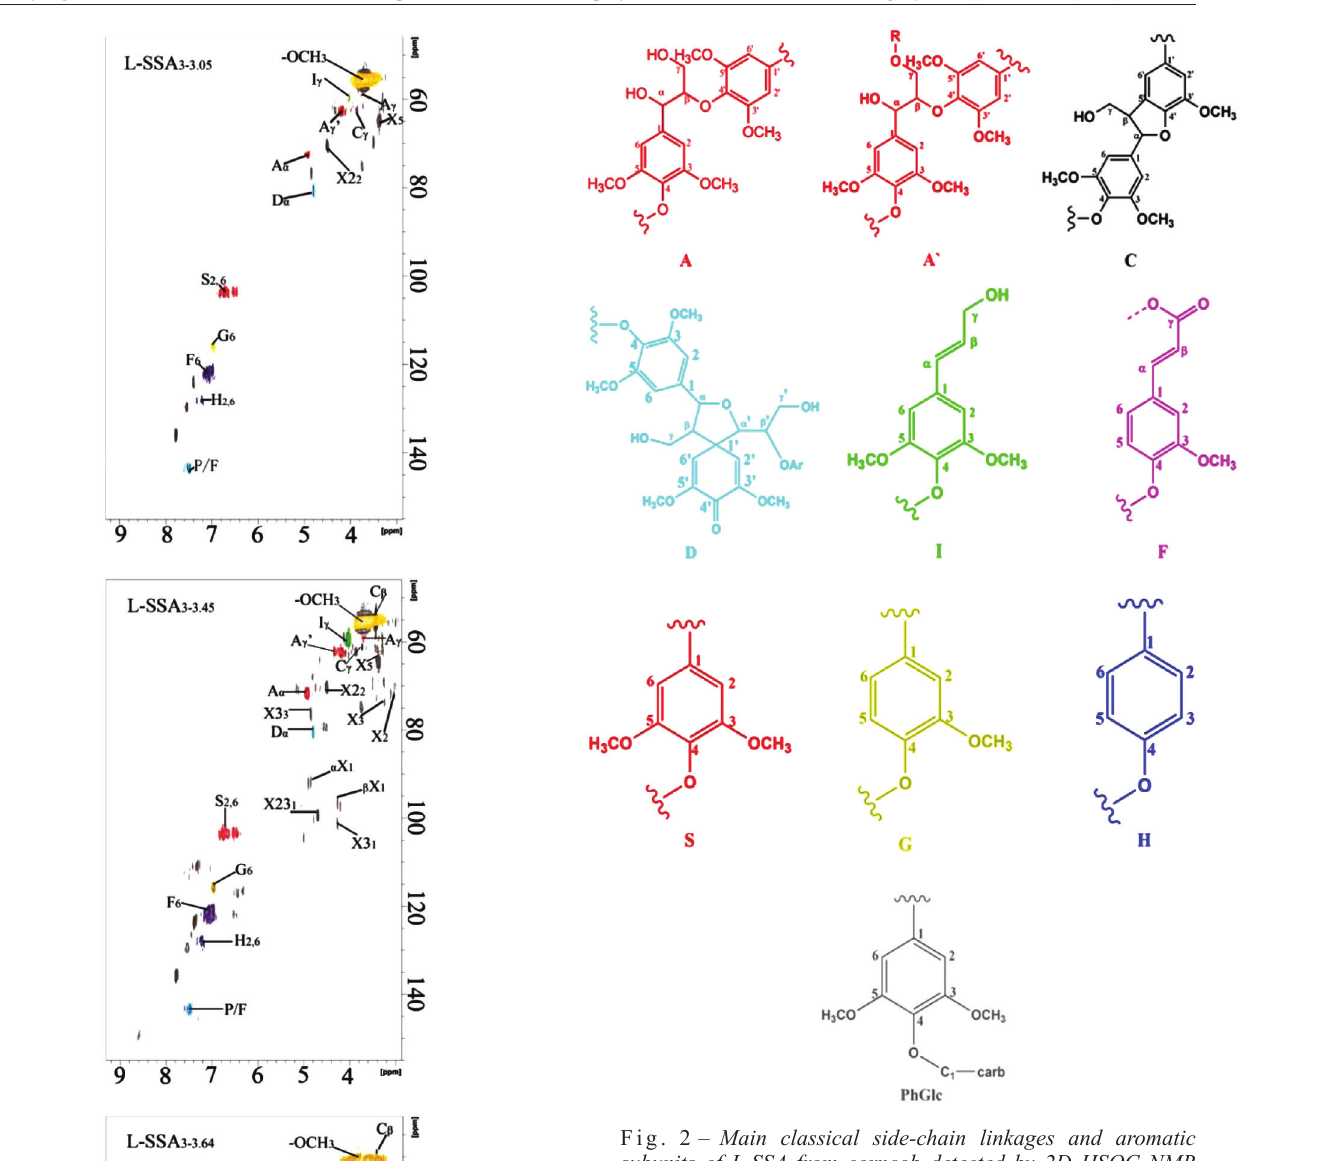
, L-SSA 3-3.05 3-3.45